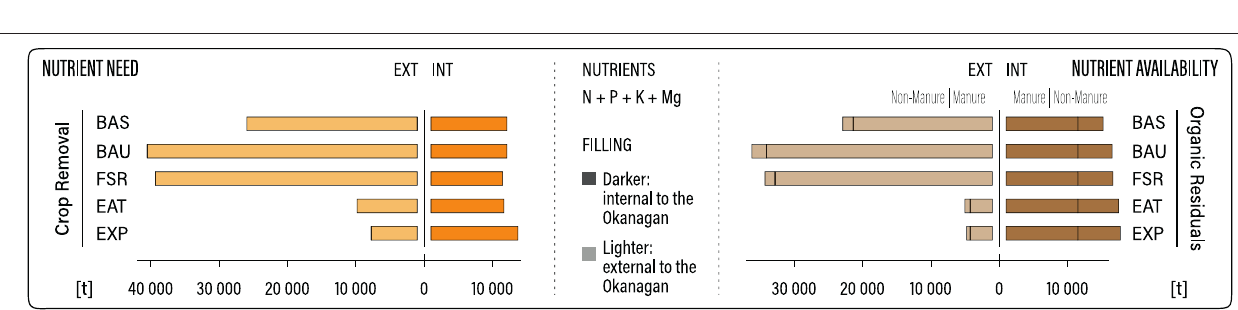
FIGURE 6 | Nutrient need (crop nutrient removal) and nutrient availability (nutrients in organic residuals) across food system scenarios. Note that the numbers for all four considered nutrient elements were added together.